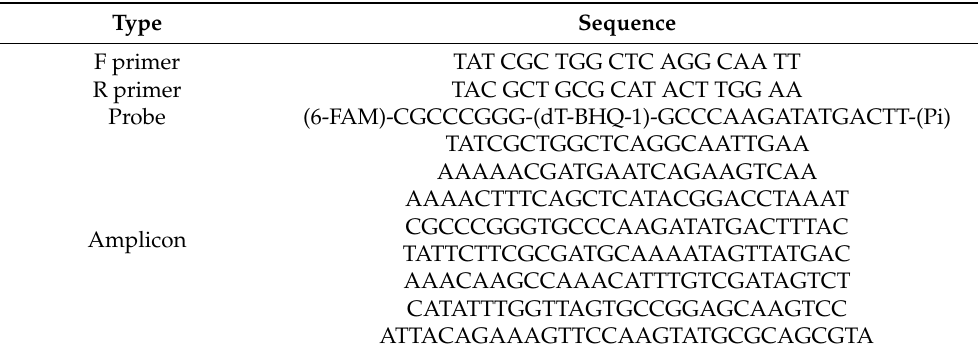
Table 1. Primers for amplification of a species-specific region and P. parmentieri and the amplicon of ankyrin repeat domain-containing protein.